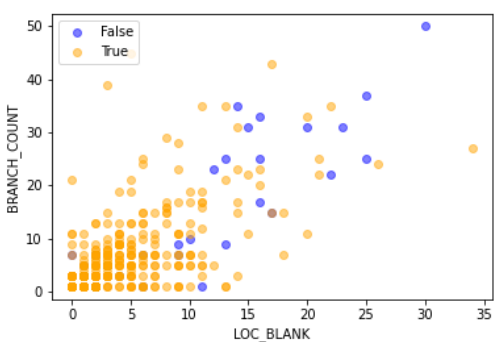
Figure 2. Class distribution on the dataset with